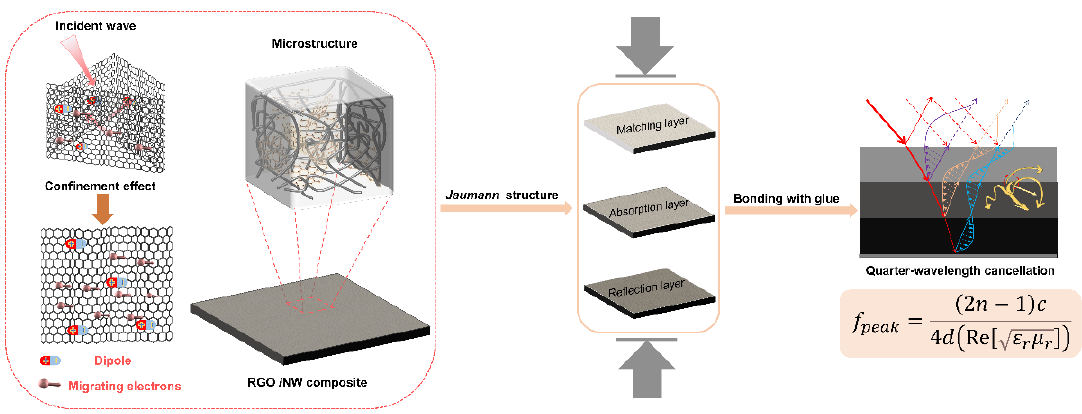
Figure 10. Schematic diagram of the wave absorption mechanism of RGO/NW.